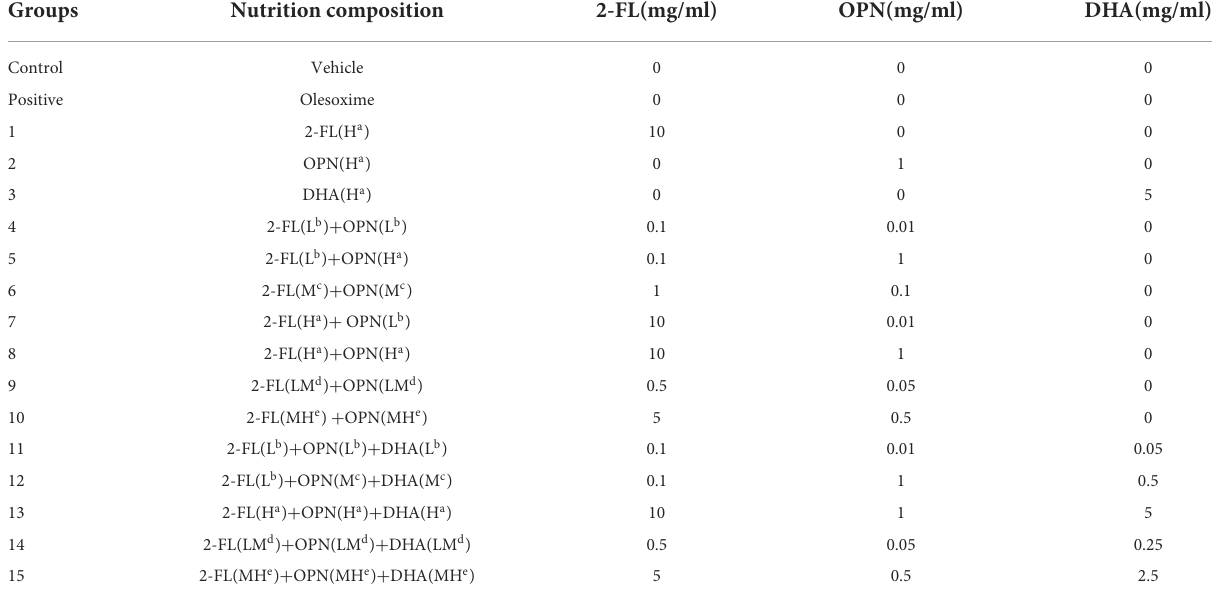
TABLE 1 Groups and dosages of the nutrition.